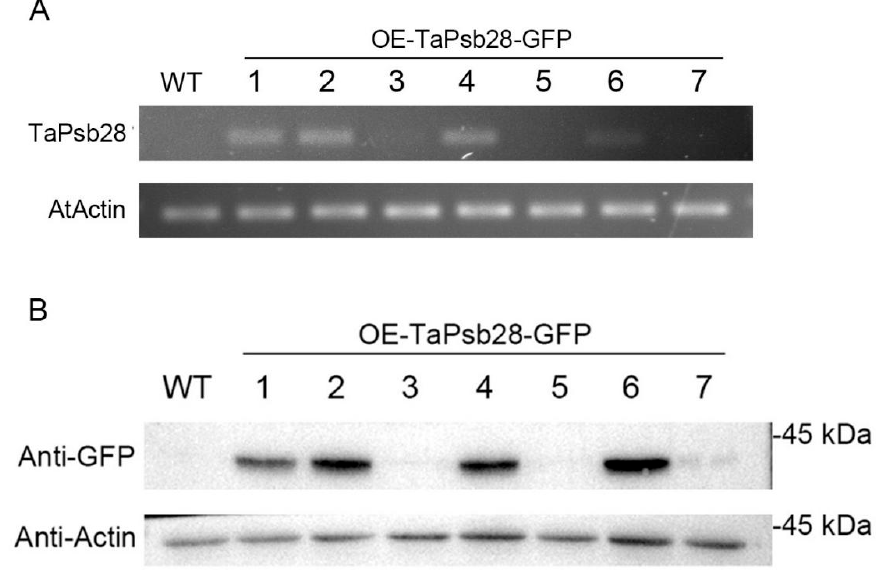
Figure 4. RT ‒ PCR ( A ) and Western blot ( B ) identification of T2-generation OE- TaPsb28 plants . Figure 4. RT–PCR ( A ) and Western blot ( B ) identification of T2-generation OE- TaPsb28